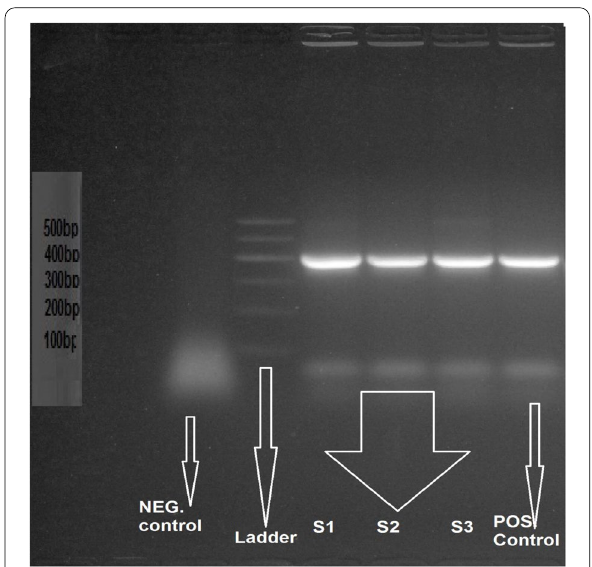
Fig. 1 Gel electrophoresis for Bile salt hydrolysis gene S1, S2, and S3 bands are probiotic bacterial isolates, beside band of positive